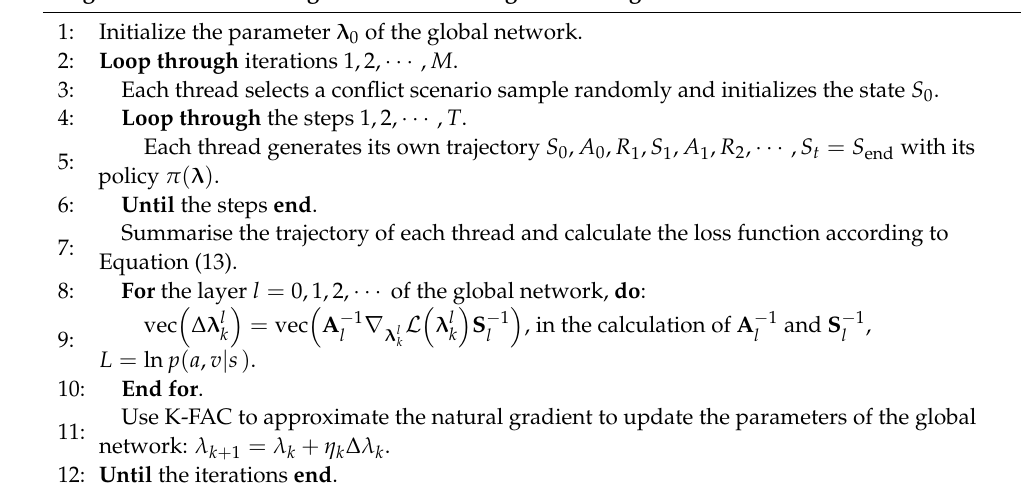
Algorithm 1: ACKTR Algorithm for Training the TCS